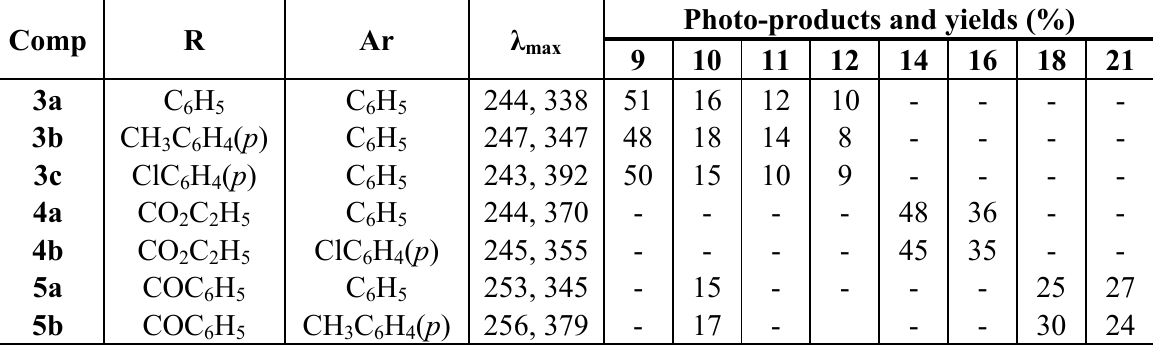
Table 3. Photoproducts formed by irradiation of compounds 3a–c , 4a , b and 5a , b and